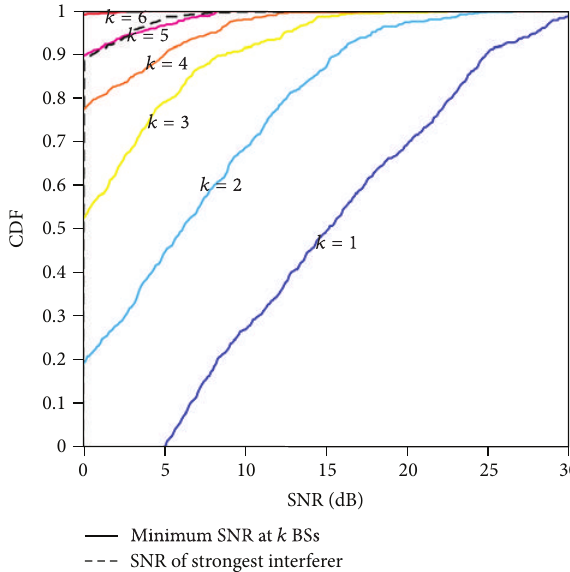
Figure 17: The same as Figure 15 but with power